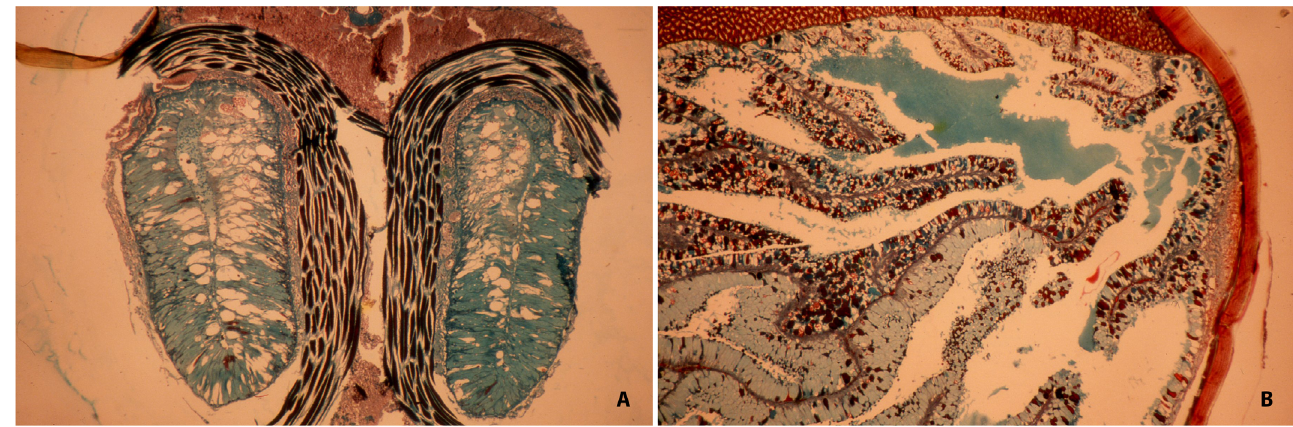
Figure 10. Histological sections of venom glands. (A) Simple, unfolded glands of Opisthacanthus africanus Simon, Hormuridae from Africa. Coloration used Trichrome de Gabe. (B) Complexly folded glands of Leiurus hebraeus (Birula), Buthidae from Israel. Coloration used Masson-Goldner.